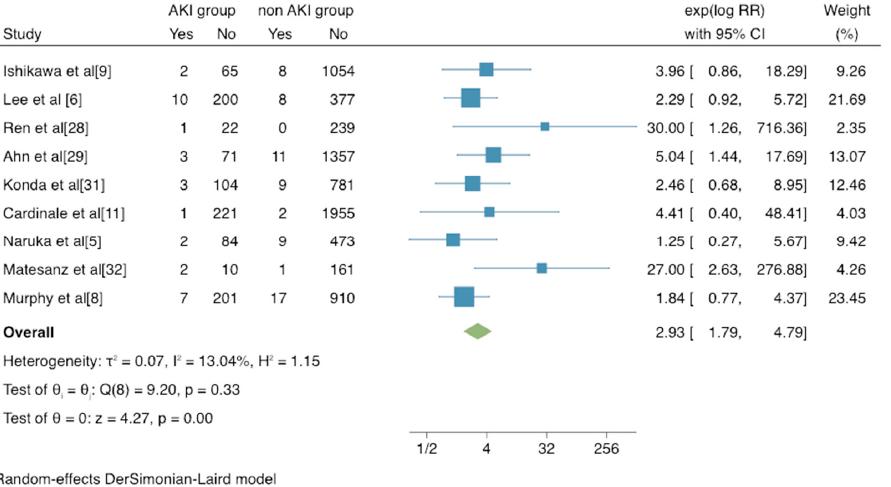
Figure 2. Forest plots of postoperative mortality in patients with/without postoperative AKI. Blue square represents RR of each study; green square represents the pooled RR of all studies. AKI, acute kidney injury; AKIN, acute kidney injury network; CI, confidence interval; RR, relative